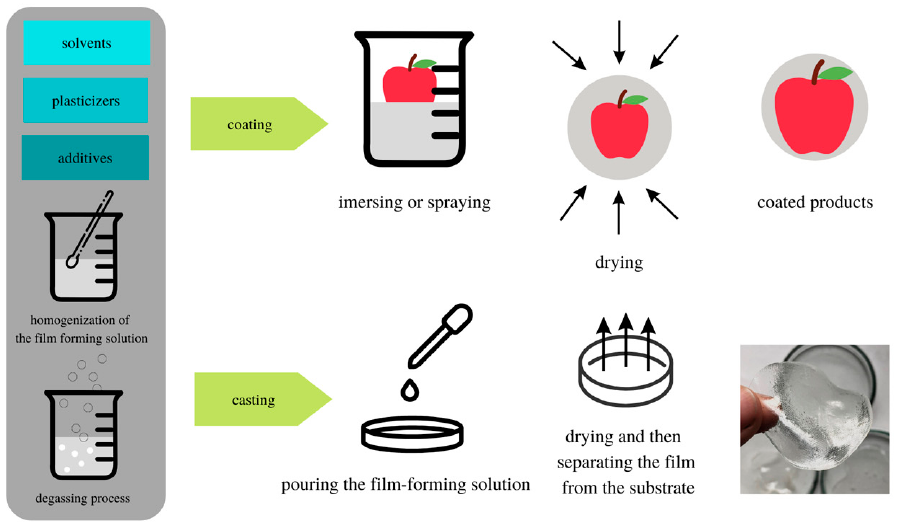
Figure 5. Scheme presenting obtaining process of chitosan ‐ based films and coatings.